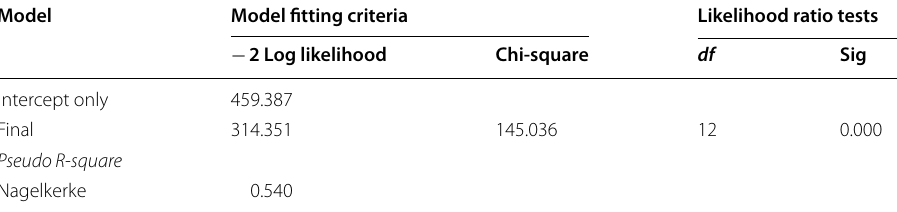
Table 7 Test of multinomial analysis